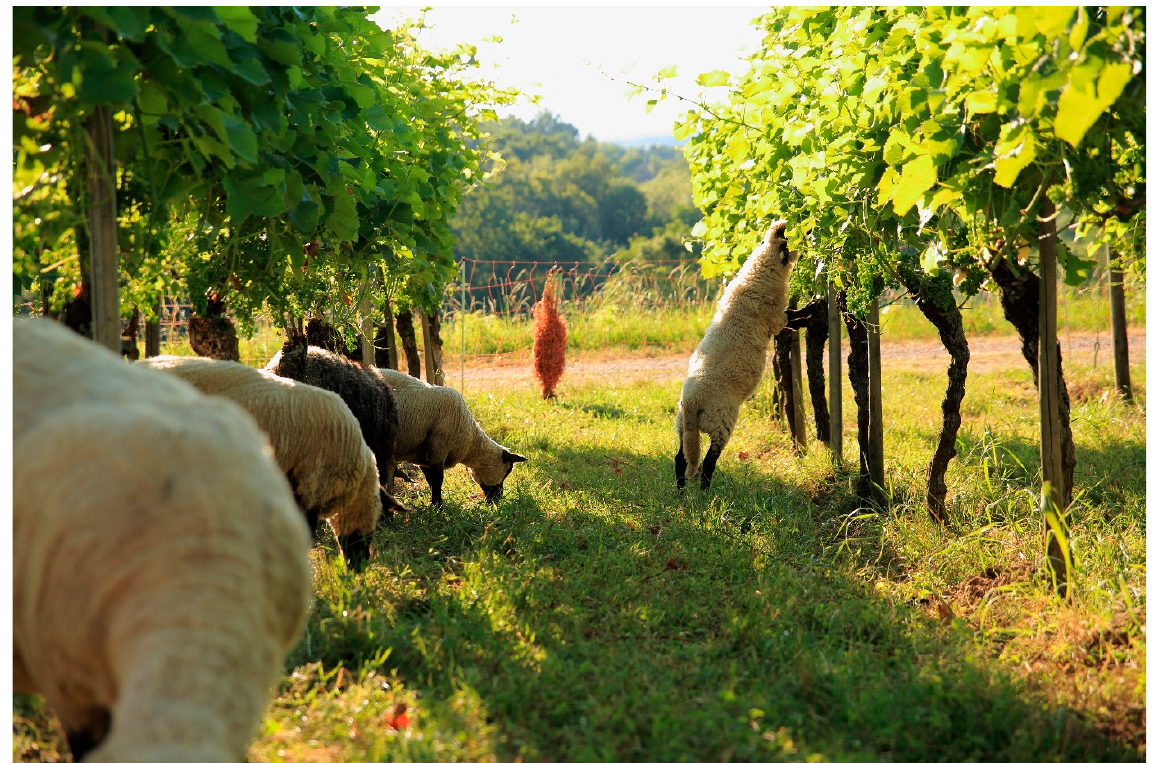
Figure 6. Sheep in bipedal stance. There are breeds suitable for grazing for several weeks during the growing season in common viticultural systems of Central Europe. Many breeds and animals are only suitable to a limited extent because they are capable of bipedal grazing, as seen here in the photo.